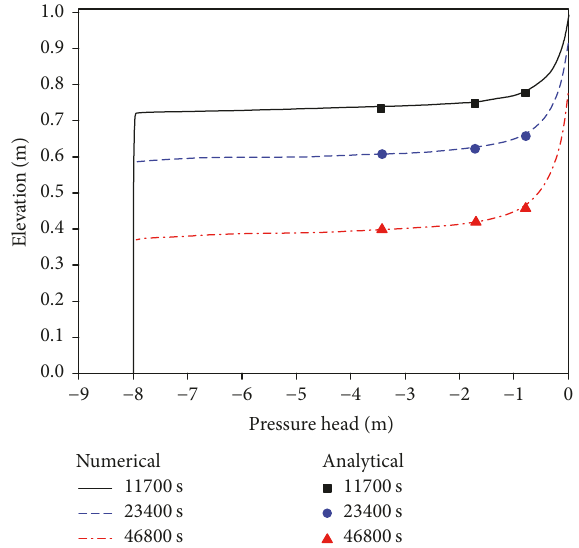
Figure 5: Simulated and analytical water table positions at various